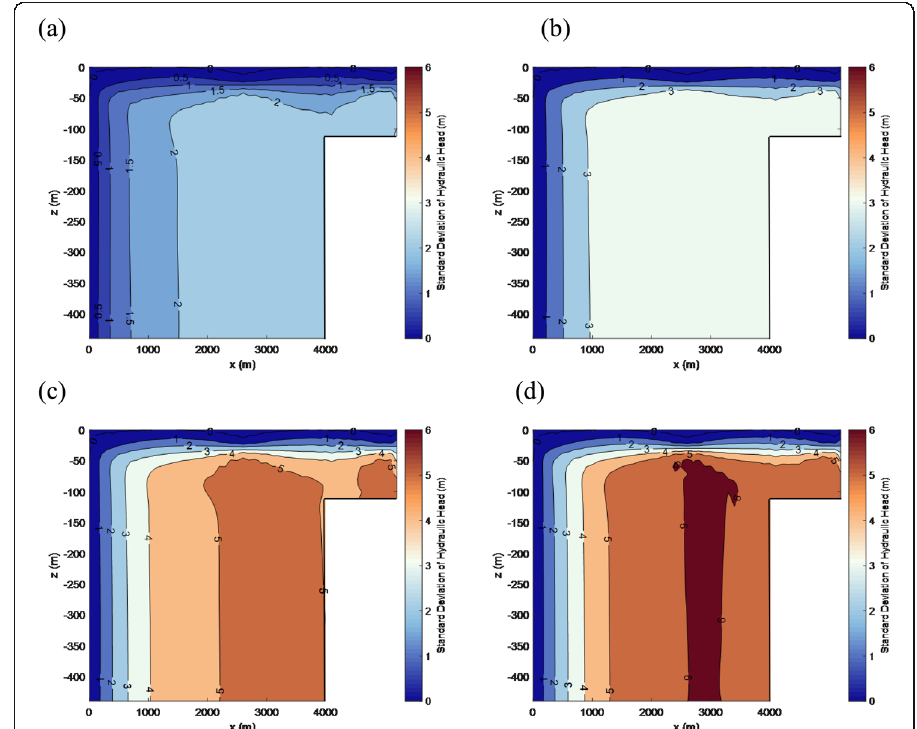
Fig. 9 Effects of the correlation length of k a on the uncertainty of hydraulic head. a l x = 200 m, l z = 40 m. b l x = 400 m, l z = 80 m. c l x = 600 m, l z = 120 m. d l x = 800 m, l z = 160